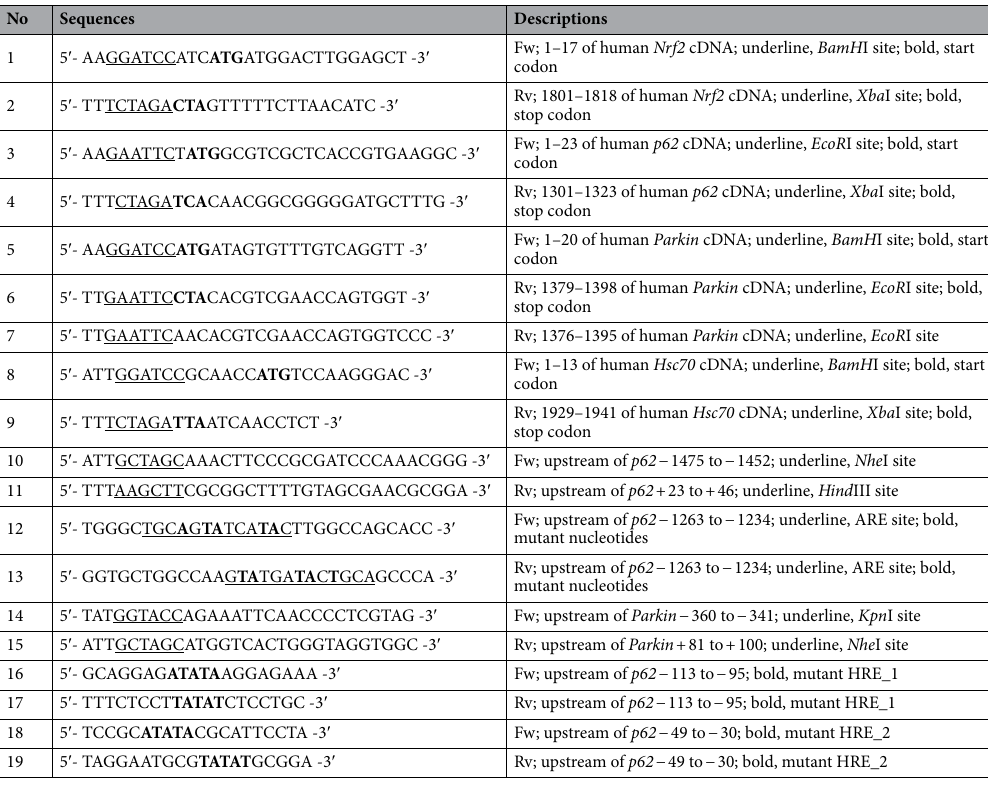
Table 1. Primers used for plasmid